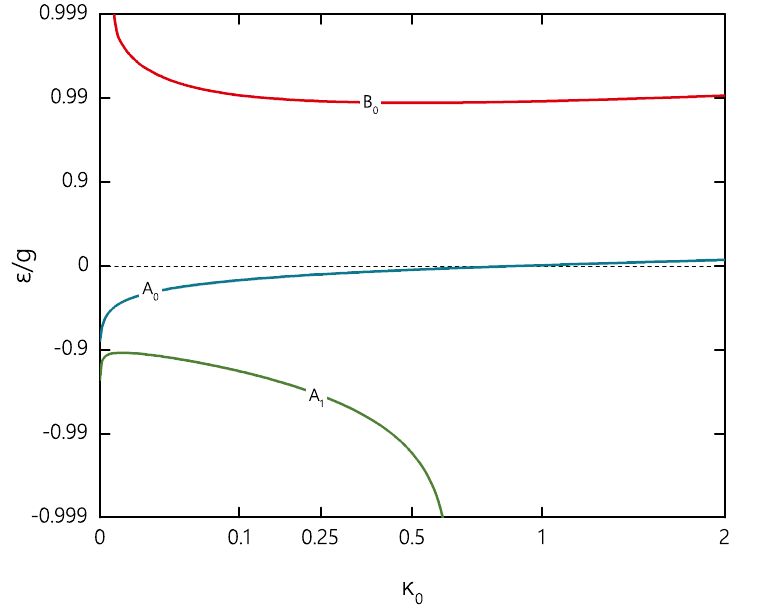
Figure 7 . Normalized energy ε of the localized fermionic states as a function of the Skyrmion g potential coupling κ 0 for several fermion modes at m = 0 and g = 1.